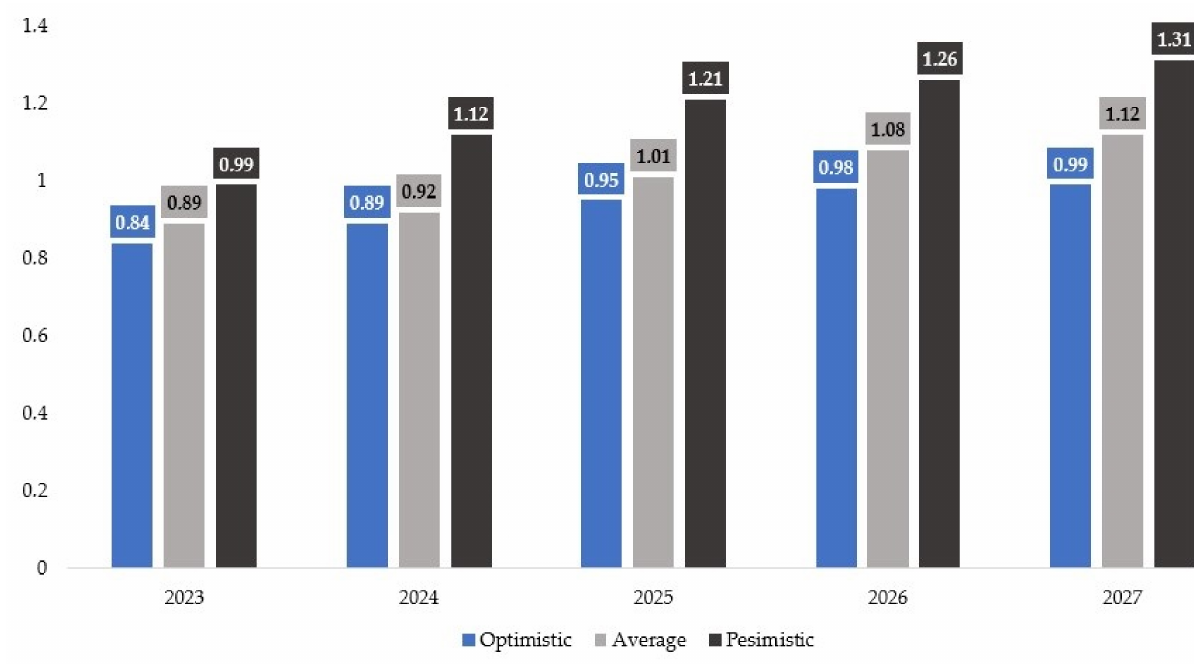
Figure 6. Electricity price forecast for households in 2023–2027